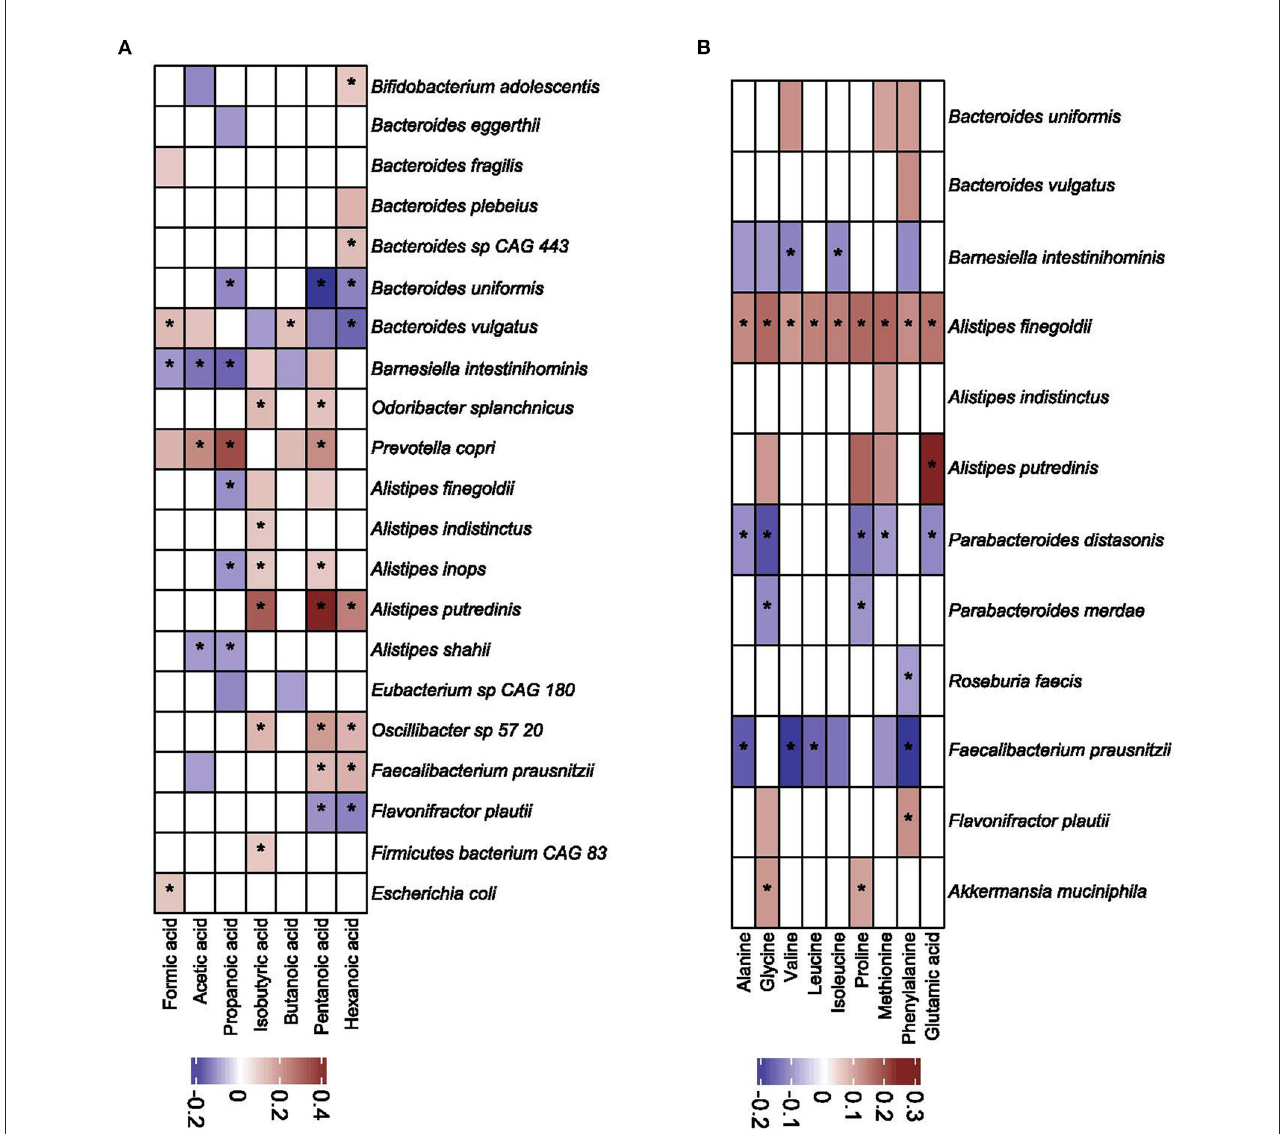
FIGURE8 Correlation coefficients (as calculated by the sparCC algorithm) between bacterial taxa and short chain fatty acids (A) and amino acids (B) . Only values higher than 0.1 are shown. Values with corresponding p- value lower than 0.05 are denoted with asterisk.